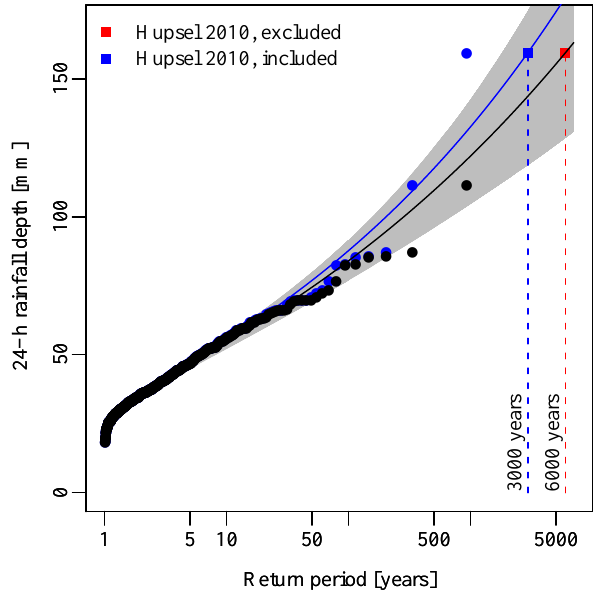
Fig. 7. Probability plot with the GEV distribution fitted to annual 24-h rainfall maxima. The method of L-moments was used (Hosk- ing and Wallis, 1997). Black points: the 514 ordered annual max- ima from Overeem et al. (2008) plotted with the Gringorten plotting position. Blue points: same data including the recent Hupsel max- imum. Lines: GEV fits. Red and blue squares: The 24-h accumu- lation of 160mm and corresponding return periods. Grey-shaded area: The 95% confidence interval based on the bootstrap